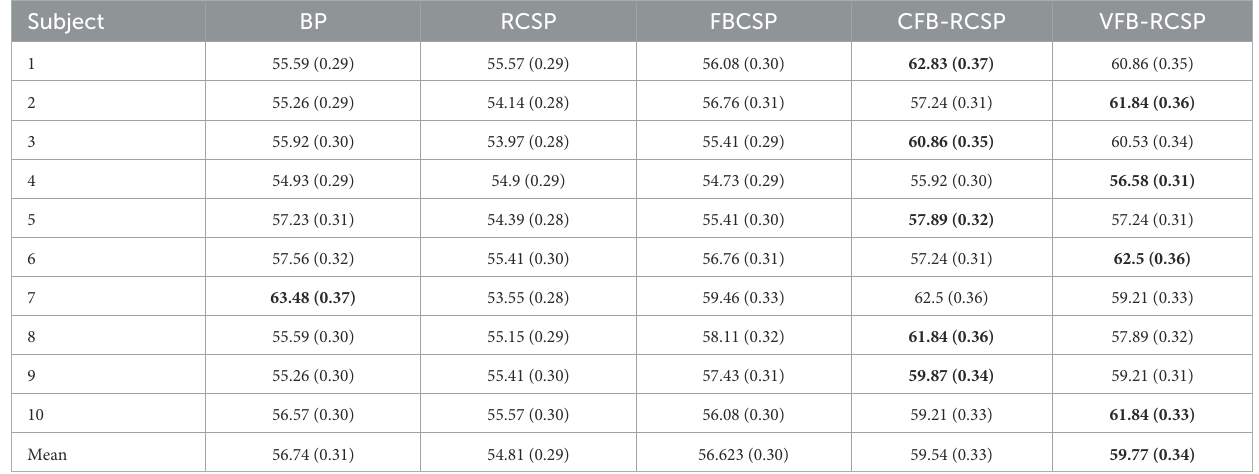
TABLE 2 Classification accuracy of the proposed method and other new methods on Dataset 2.